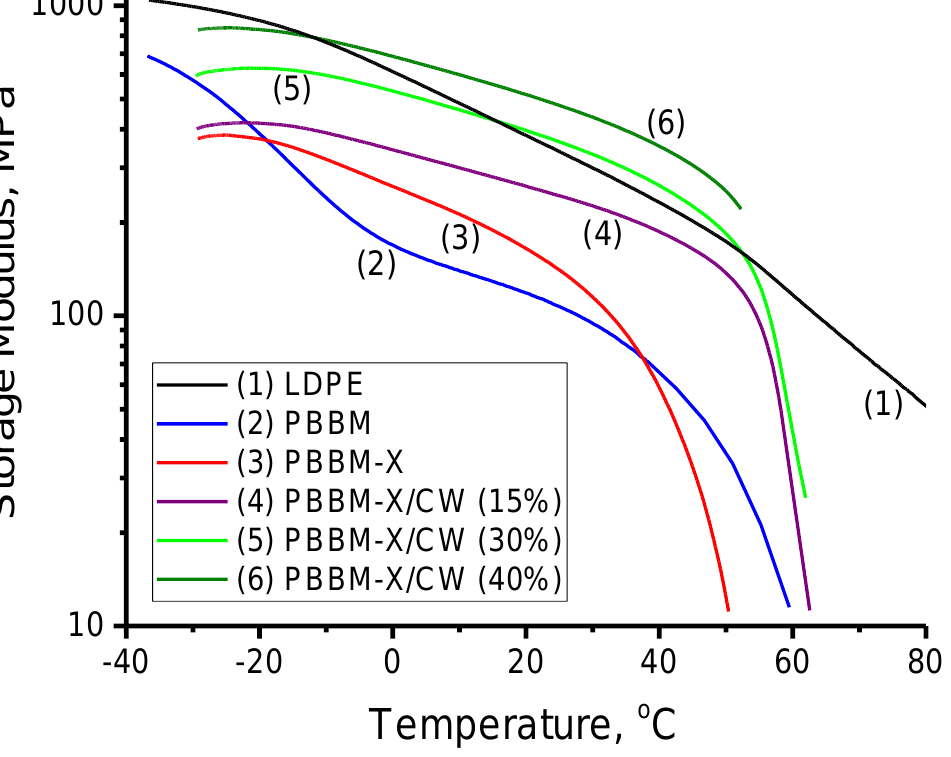
Figure 7. Storage modulus versus temperature for the bioplastics.